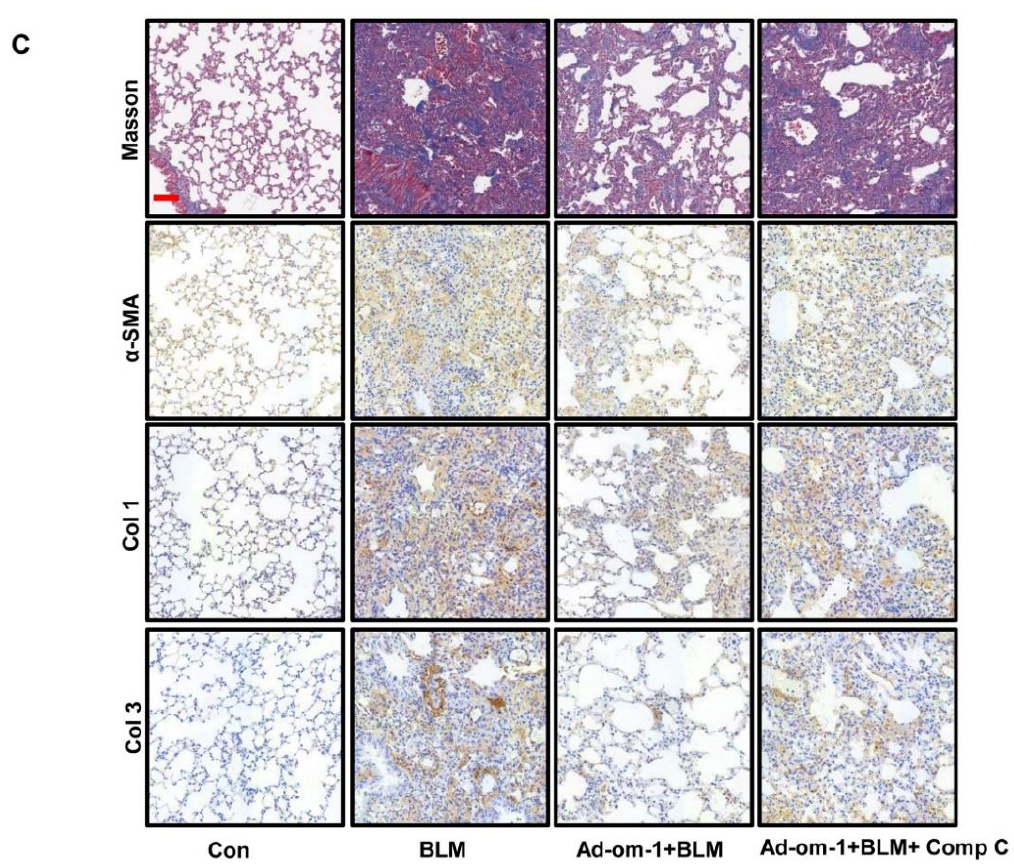
Figure 6. The effect of omentin-1 mediated by activation of AMPK pathway in vivo. ( A ) The level of p-AMPK in lung tissue detected by immunofluorescence after BLM challenge for 14 d and ad- omentin-1 preventative treatment (up: 200 × , lower: 400 × , bar = 50 µ m, n = 3); ( B ) Representative micrographs of H&E staining of lung tissue (Bar = 50 µ m, n = 3). ( C ) Representative micrographs of Masson trichrome staining, immunohistochemical staining of lung sections for α -SMA, Col1 and Col3 (Bar = 50 µ m, n = 3).